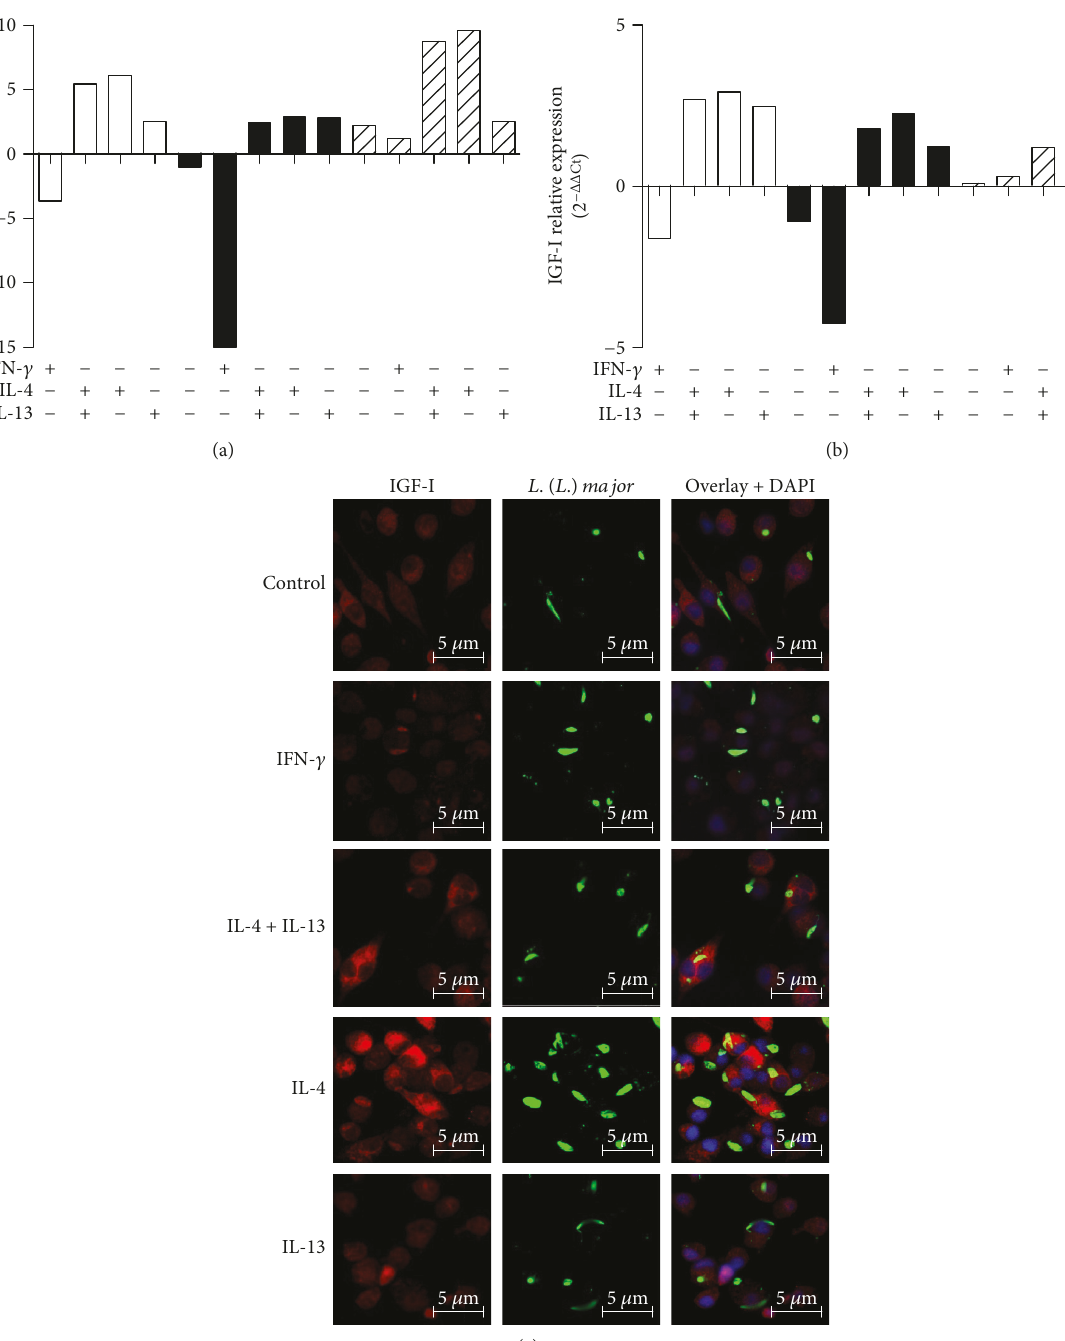
Figure 2: IGF-I expression in response to cytokine treatment. (a and b) Quanti fi cation of Igf-I mRNA in L. major promastigote- (black bars) or amastigote-infected (striped bars) or noninfected (white bars) RAW 264.7 cells (a) and BALB/c peritoneal macrophages (b) is shown. Cells were stimulated with IFN- γ (200U/mL), IL-4 (2 ng/mL), and IL-13 (5 ng/mL) for 48hours. One representative experiment from three independent assays is shown. (c) Detection of IGF-I expression using confocal microscopy of cells labeled with a 1:75 dilution of an anti- IGF-I antibody (using an Alexa Fluor 546-conjugated secondary antibody; red) and a 1 :200 dilution of an anti- Leishmania antibody (using an Alexa Fluor 488-conjugated secondary antibody; green) in L. major promastigote-infected macrophages is shown. Nuclei were stained with DAPI (blue). Images were captured using a confocal Leica LSM510 microscope with a 63x oil immersion objective. The expressions are relative to the expression in untreated cells (the